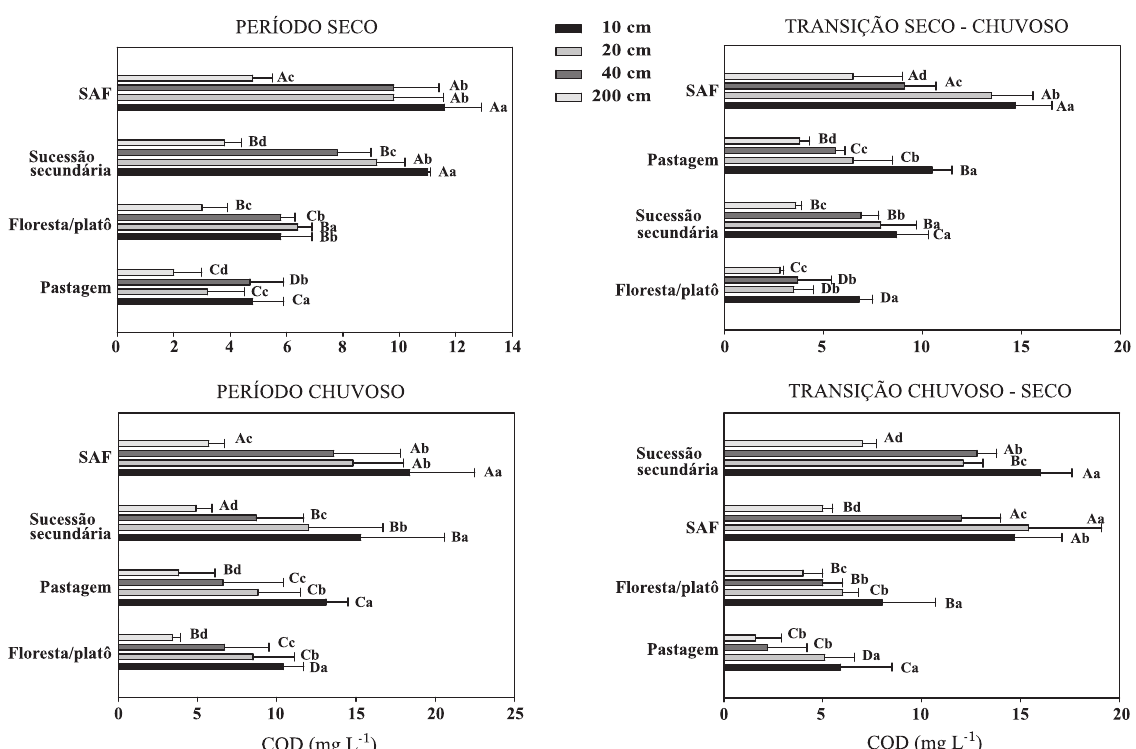
Figura 3. Concentrações de Cod na solução do solo em diferentes períodos do ano (seco, chuvoso e transições). a letra maiúscula compara as profundidades semelhantes entre os ambientes, e a minúscula, as profundidades diferentes entre si dentro do mesmo ambiente. (tukey, p <